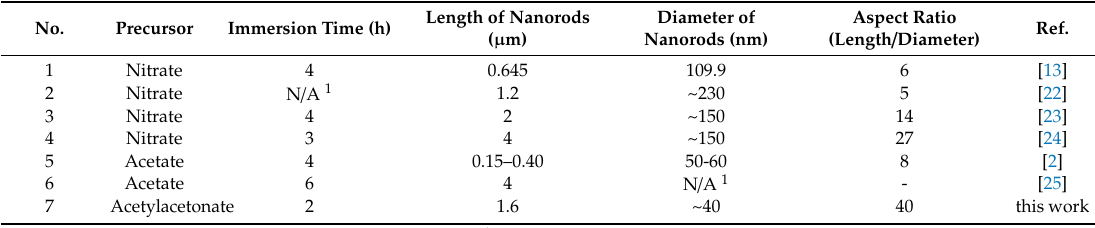
Table 1. Minimal immersion time to grow ZnO nanorods (NRs) on a seeded substrate using various types of precursors with their dimensionality of obtained nanorods.